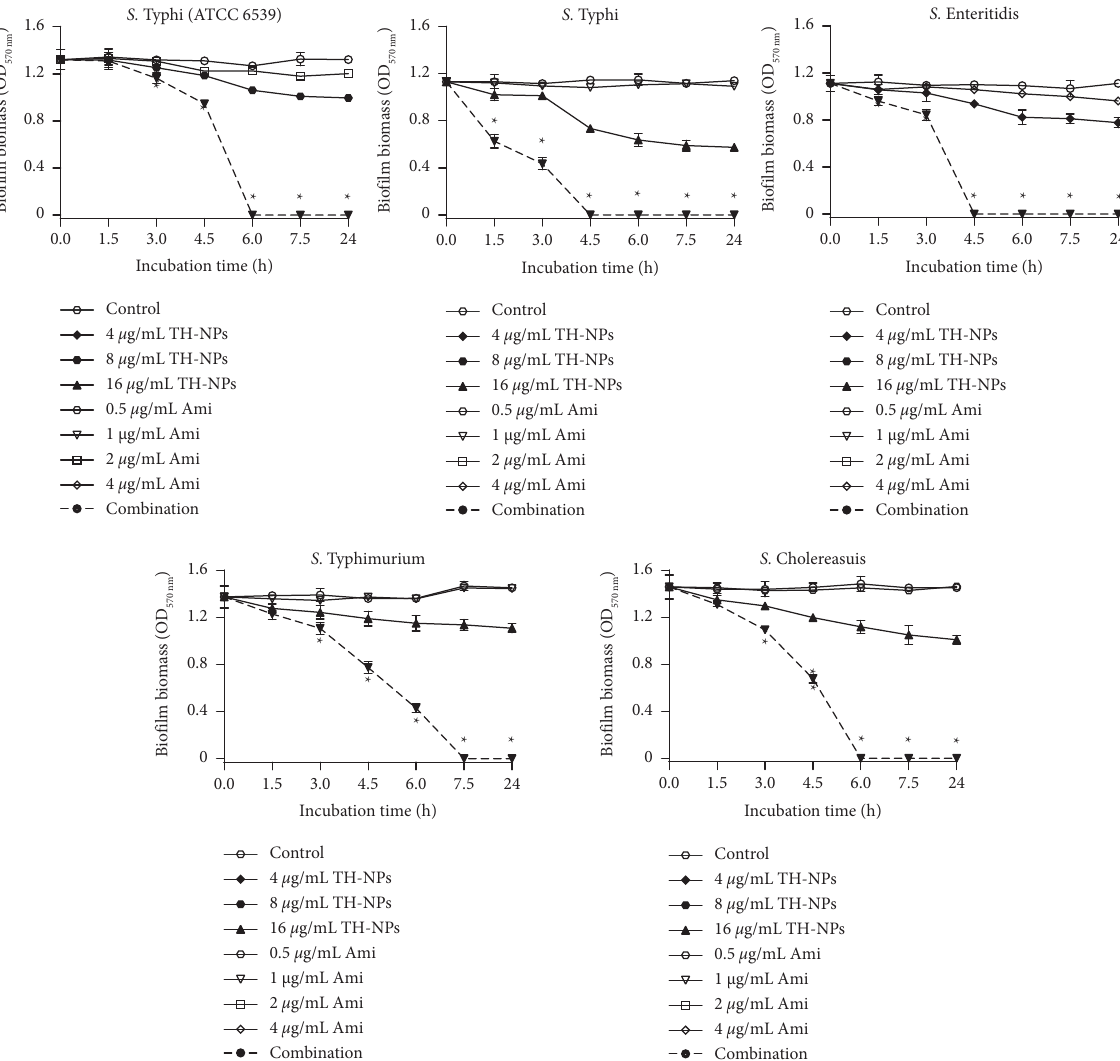
Figure 3: Kinetic study of TH-NPs alone or in combination with amikacin against disruption of preformed bioflm of S. enterica serovars. TH-NPs: thymol-loaded PLGA nanoparticles, Ami: amikacin. Data represent the average values and standard deviation of three in- dependent experiments. ∗ Signifcant diference between the combination and TH-NPs alone ( p <